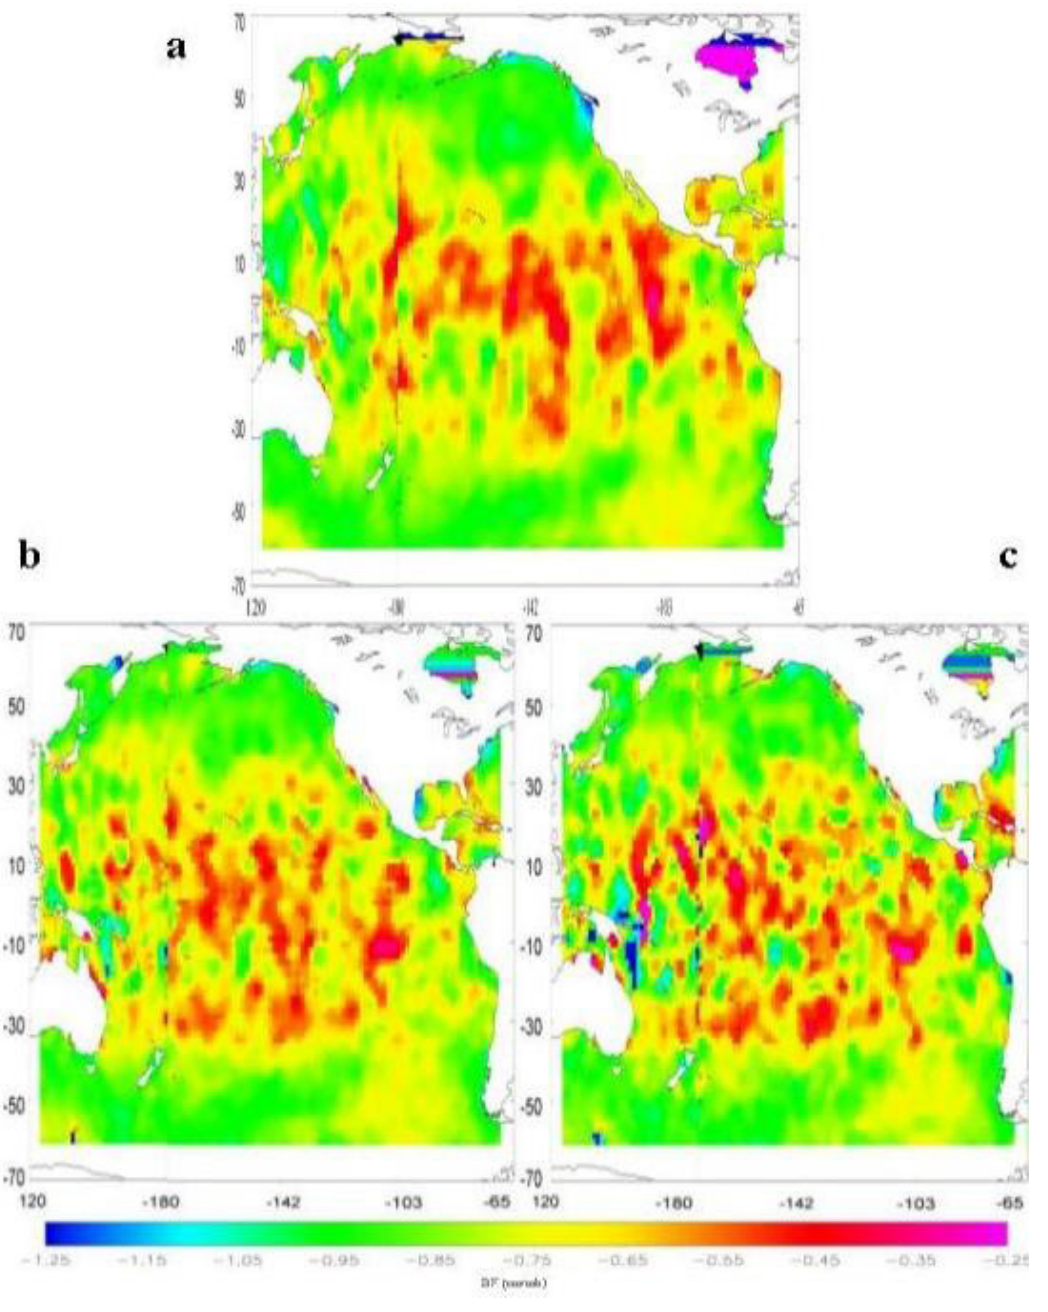
Fig. 7. As Fig. 3, in the case of the Pacific Basin.